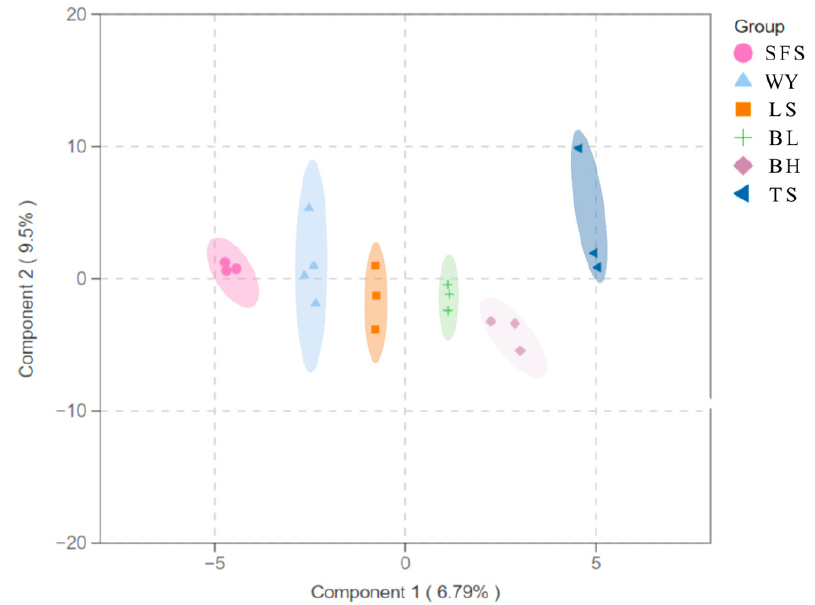
Figure 2. OPLS-DA score plot of primary metabolites at different latitudes of T. amurensis. Different colors represent different sampling points.